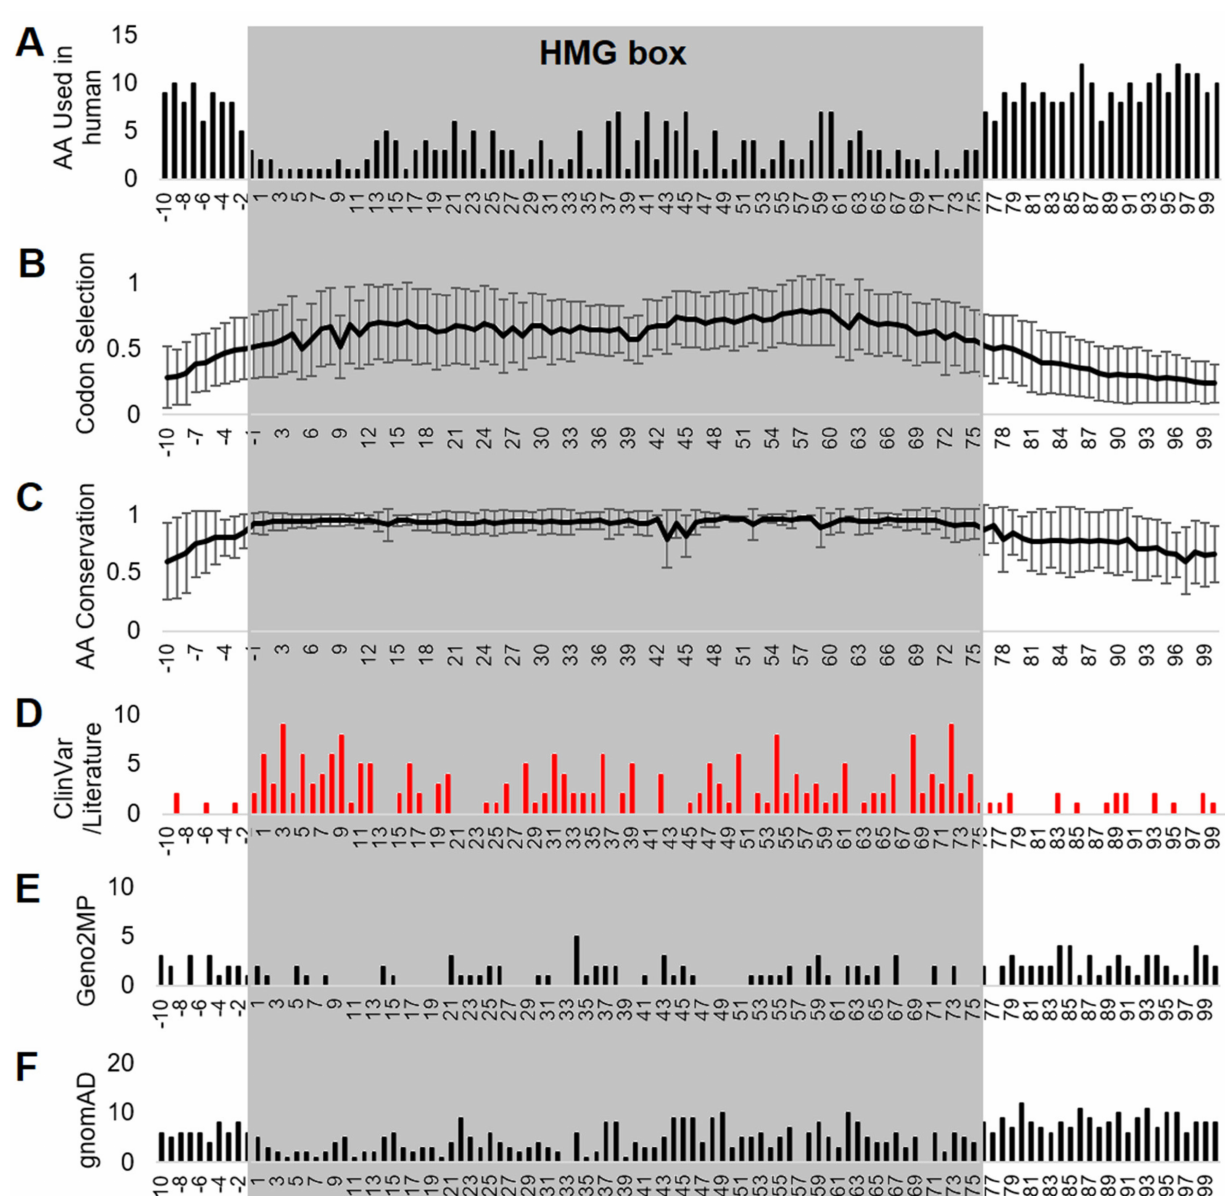
Figure 4. HMG box alignment of all SOX proteins. Alignment of all HMG box sequences of the 20 SOX proteins showing the number of human amino acids used ( A ), codon selection scores ( B ), conservation ( C ), and genomic variants for different SOX proteins using ClinVar or the literature ( D ), Geno2MP ( E ), or gnomAD ( F ). Error bars for panels ( B , C ) represent plus and minus the standard error of the mean over all 20 genes/proteins. Amino acid 1 is the V/I annotated within UniProt as the first amino acid of the HMG box for each protein. Alignments were performed without any